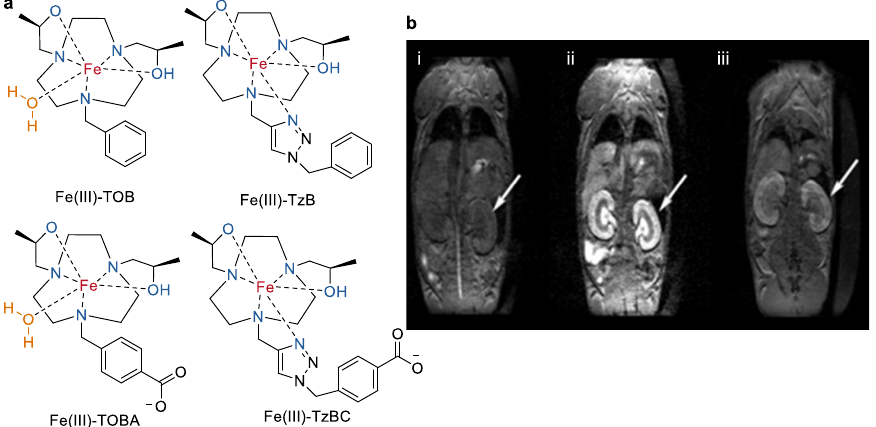
Figure 6. ( a ) Chemical structures of mononuclear Fe(III) complexes of Fe(III) – TOB, Fe(III) – TOBA, Fe(III) – TzB, and Fe(III) – TzBC. ( b ) T 1-weighted MRI images of a healthy Balb/C mouse before and after injection of 0.05 mmol/kg Fe(III) – TOB at 4.7 T. Enhancement of kidneys (arrow) ( i ) before, ( ii ) 45 min, and ( iii ) 4 h post-injection [54]. Reprinted/adapted with permission from Ref. [54].